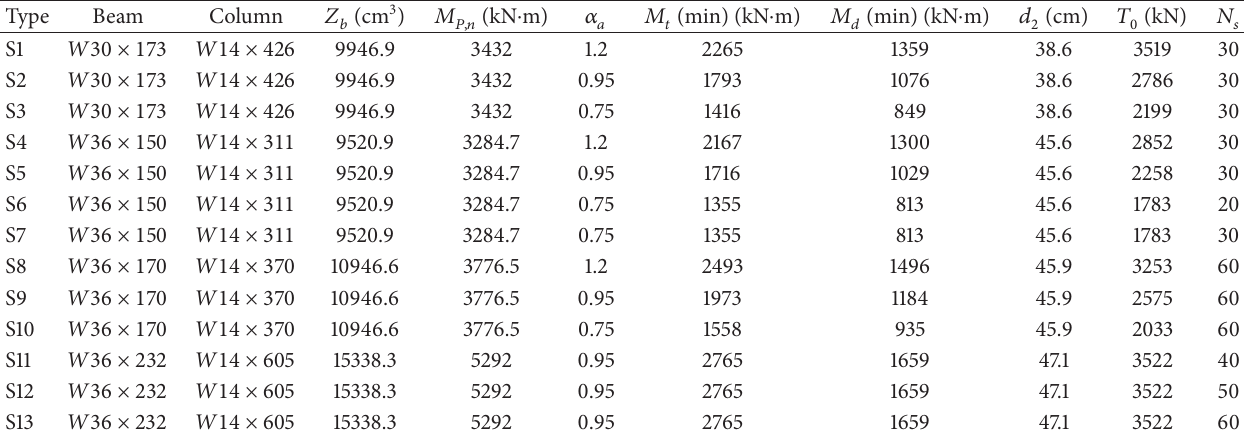
Table 2: PTTC specimens.